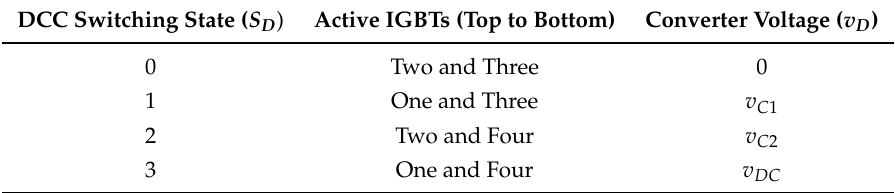
Table 2. DC-DC converter switching